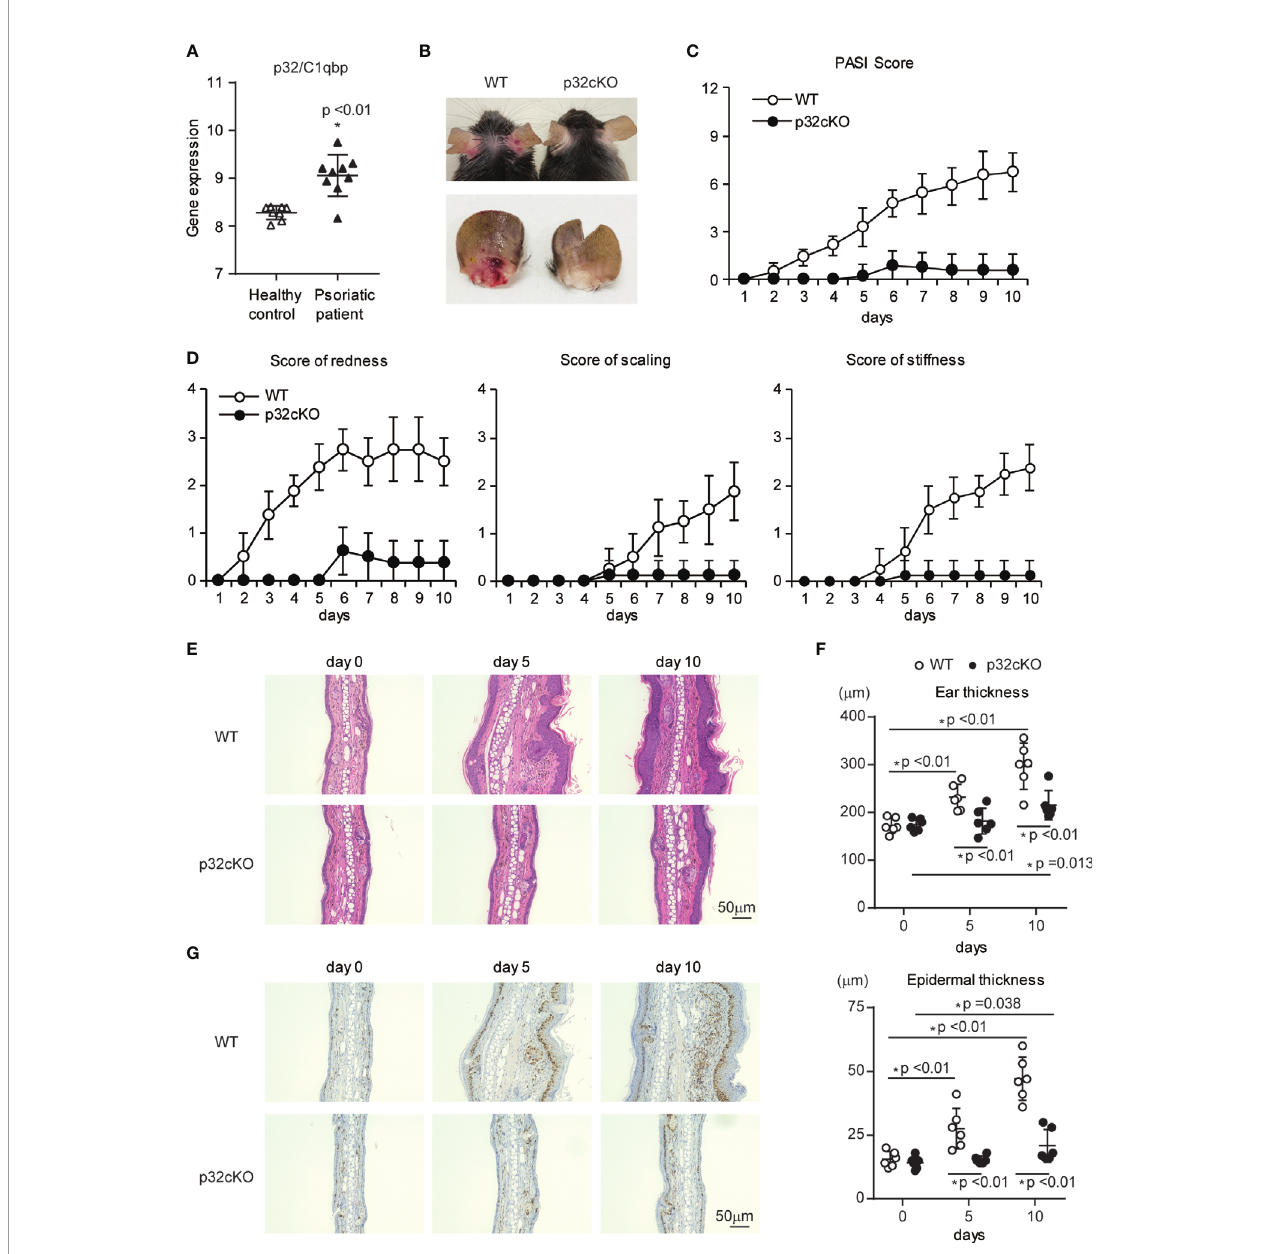
FIGURE 1 | Effects of p32/C1qbp de fi ciency on psoriatic in fl ammation. (A) Gene expression patterns of p32/C1qbp in lesions from patients with psoriasis (n = 9) versus healthy individuals (n = 8) from Gene Expression Omnibus (http://www.ncbi.nlm.nih.gov/geo; accession number GSE75890). (B – D) WT and p32cKO mice were topically treated with IMQ for 9 consecutive days. Representative gross appearances of ears from WT and p32cKO mice that were treated daily with topical IMQ (B) . Cumulative Psoriasis Area Severity Index (PASI) scores (C) were calculated based on the individual scores for redness, scaling, and stiffness (D) daily until 9 days after IMQ application. Data are shown as means ± SDs (n = 8). (E – G) Microscope images of cross-sections of mouse ears stained with hematoxylin and eosin (E) and subjected to immunohistochemical analysis of Ki-67 (G) . Changes in ear ( F upper) and epidermal ( F lower) thickness over time. Scale bars, 50 µm. Data are shown as means ± SDs (A, C, D , F) . *p < 0.05 versus WT mice. Data are representative of at least three (A – G) independent